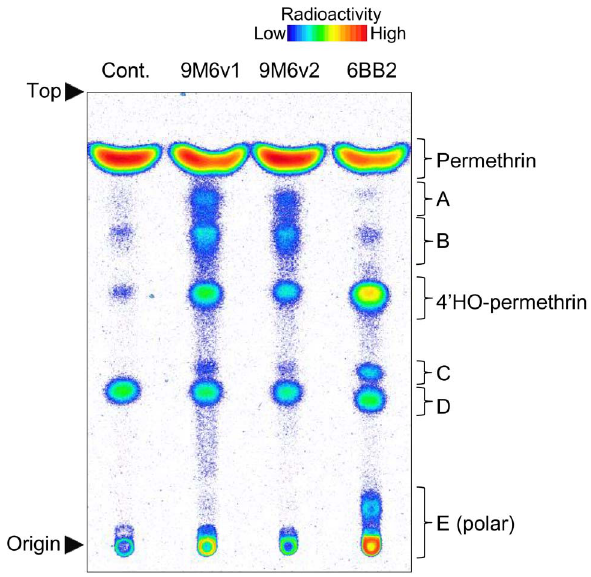
Figure 8. Thin layer chromatogram of [ 14 C]-permethrin metab- olites by heterologously expressed CYP9M6v1, CYP9M6v2, and CYP6BB2. A-E denote unidentified metabolites. Developing solvents: toluene/ethyl acetate (6:1). The presence of 4 9 -HO-permethrin was determined by co-chromatography with an authenticated chem- ical.